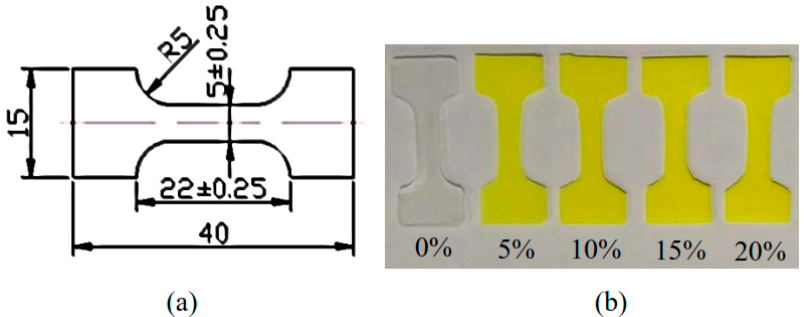
Figure 2. ( a ) geometric dimension of test samples; ( b ) the prepared test samples with different phosphor mass fractions.